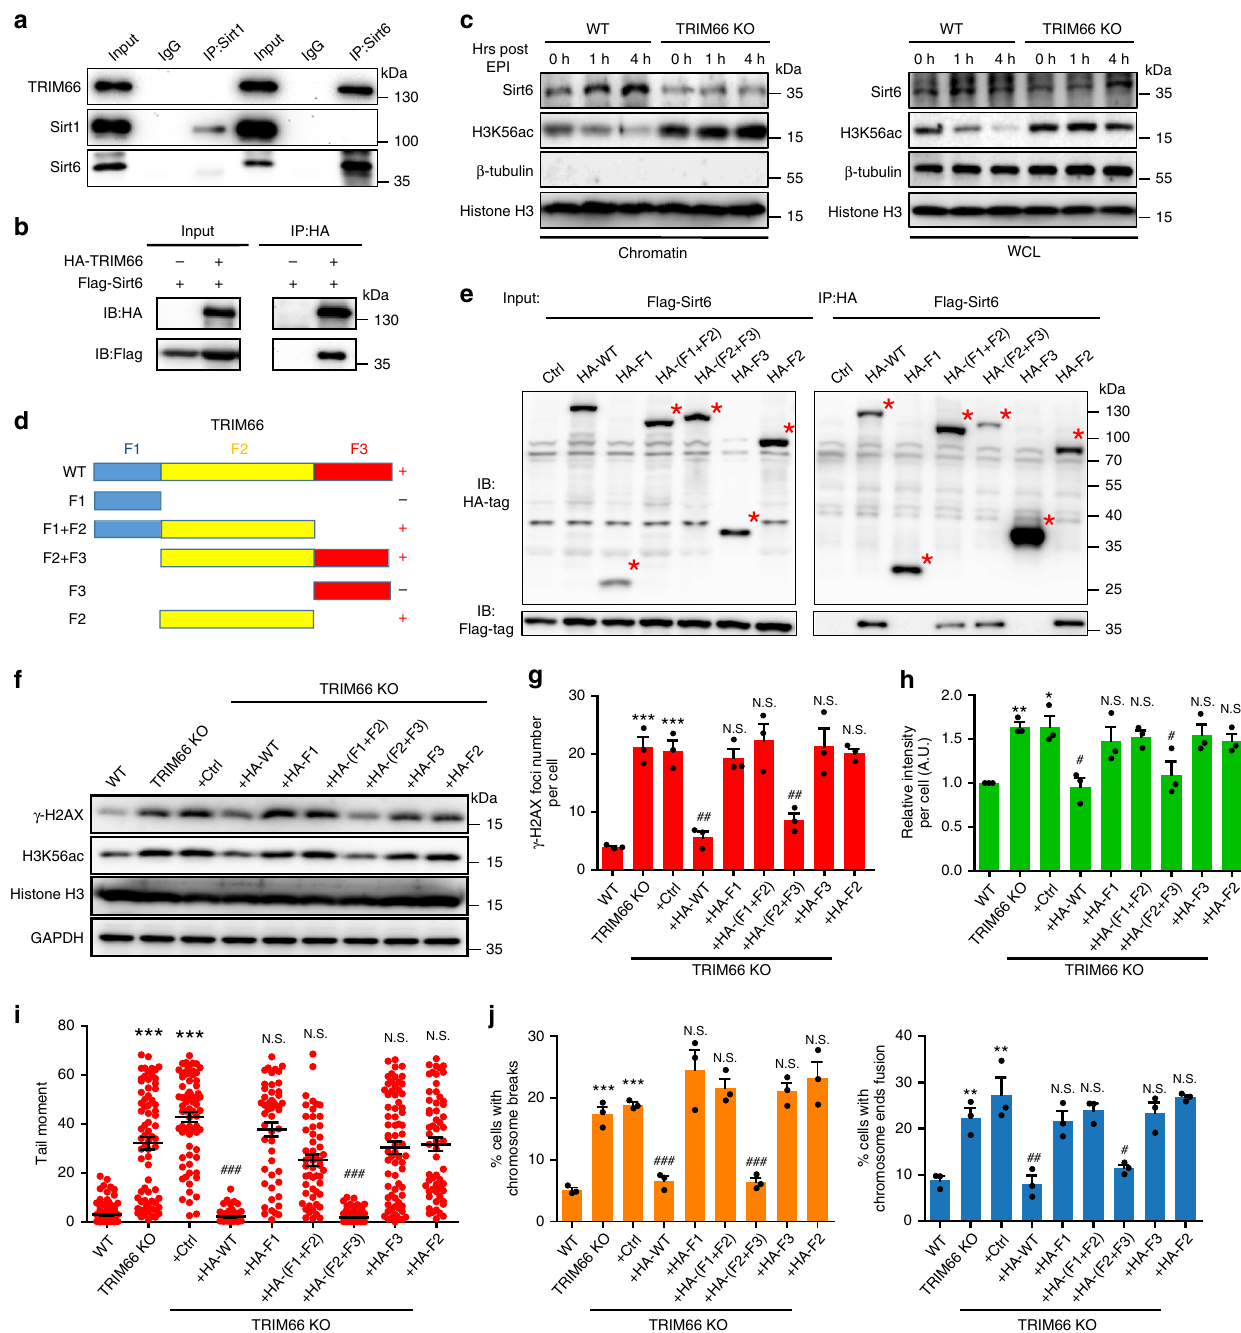
Fig. 6 TRIM66 recruits Sirt6 to deacetylate H3K56ac and safeguard genomic stability in ESCs. a , Co-immunoprecipitation analysis between Sirt1/Sirt6 and TRIM66 in ESCs. b HA immunoprecipitation analysis in 293T cells showing the interaction between TRIM66 and Sirt6. c Immunoblot analysis of the cell fractionation in WT and TRIM66-KO ESCs at different time points after treatment with EPI. d Schematic representation of WT TRIM66 and the truncated mutant proteins. e Immunoblot analysis of WT TRIM66 and truncations associated with Sirt6, which is marked by red plus sign in d , whereas the truncations not interacting with Sirt6 are marked by the black minus sign. Anti-HA immunoprecipitates are prepared from 293T cells transfected with Flag- tagged Sirt6 and HA-tagged WT TRIM66, and truncations followed by immunoblot. f Immunoblot analysis of the levels of γ -H2AX and H3K56ac in WT, TRIM66-KO ESCs, and the TRIM66-KO ESC-overexpressed control plasmid, HA-tagged WT TRIM66, and the truncated mutants of TRIM66. g Quanti fi cation of the γ -H2AX foci formation in ESCs described in f . More than 200 cells are examined in each sample. h Quanti fi cation of H3K56ac detected by immuno fl uorescence analysis in ESCs described in f . More than 200 cells are examined in each sample. i DNA integrity assessment of ESCs described in f by comet assay. More than 100 cells are examined in each sample. j Quanti fi cation of chromosomal breakage (left) or chromosome ends fusion (right) in ESCs as described in f . More than 200 cells are examined in each sample. *represents a difference from WT ESCs, # indicates a difference from TRIM66-KO + Ctrl. Data are presented as the means ± SEM. Statistical signi fi cance is determined by two-tailed Student ’ s t -test. * # p < 0.05, ** ## p < 0.01, *** ### p < 0.001, N.S., no signi fi cance. Source data are provided as a Source Data fi le